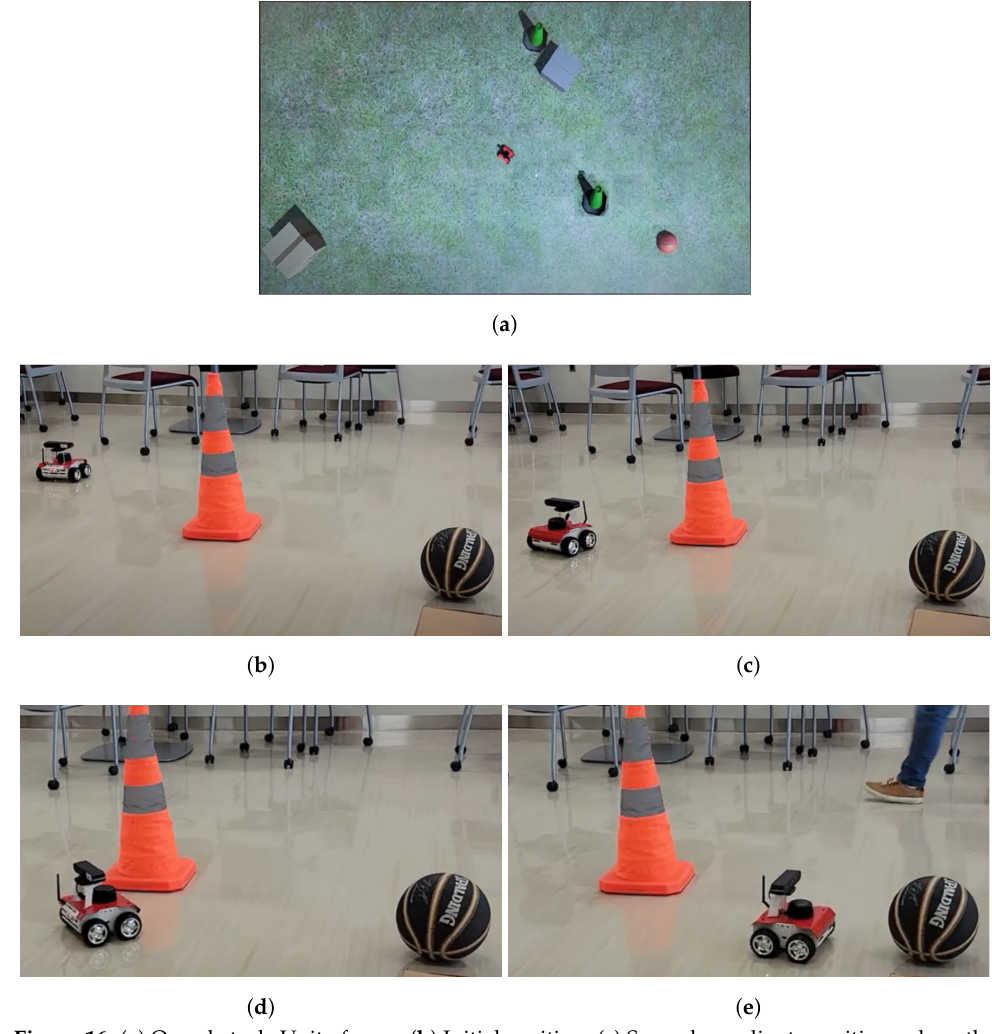
Figure 16. ( a ) One obstacle Unity frame. ( b ) Initial position. ( c ) Second coordinate position, where the rover’s obstacle avoidance keeps a distance from the cone. ( d ) Third coordinate position, where the rover swerved around the cone. ( e ) Final coordinate position, where the rover has reached the